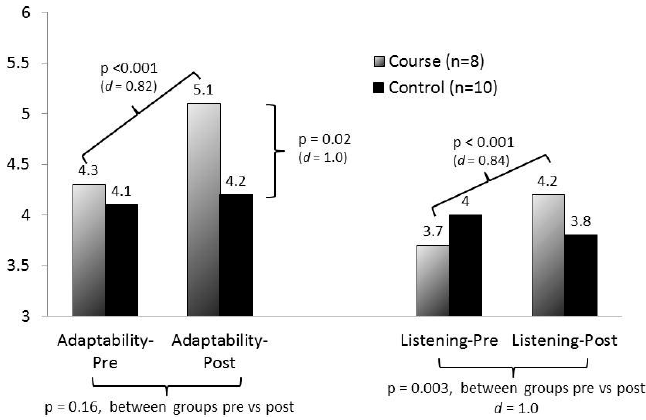
Figure 2. Standardized patient evaluations.